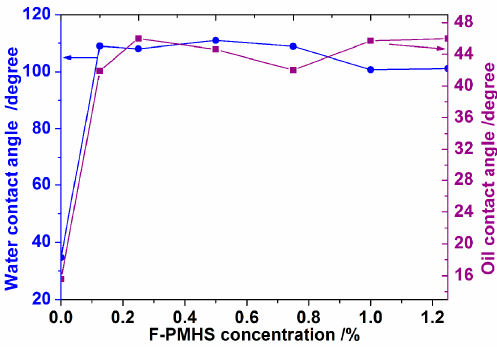
Figure 5. Effect of F-PMHS content on the water and oil contact angles of ARCs.